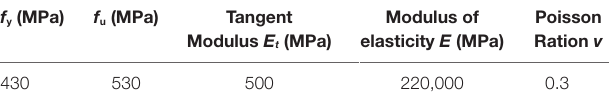
TaBle 6 | Material properties used in